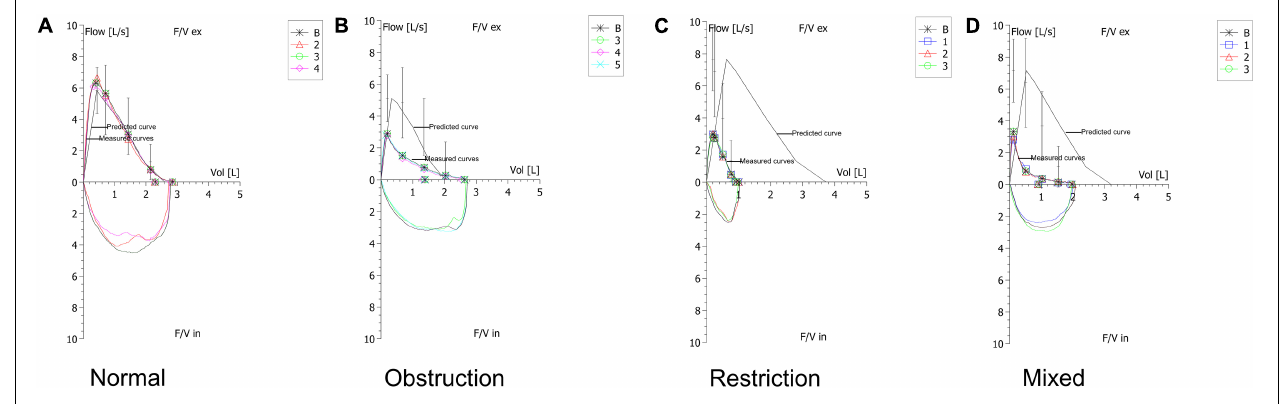
FIGURE 2 | Typical examples of ventilatory patterns of spirometry. (A) Example of a normal pattern. (B) Example of an obstructive pattern that shows a concave shape on the expiratory flow. (C) Example of a restrictive pattern that shows a convex shape on the expiratory flow. (D) Example of a mixed pattern that shows characteristics of coexistence of obstruction and restriction.